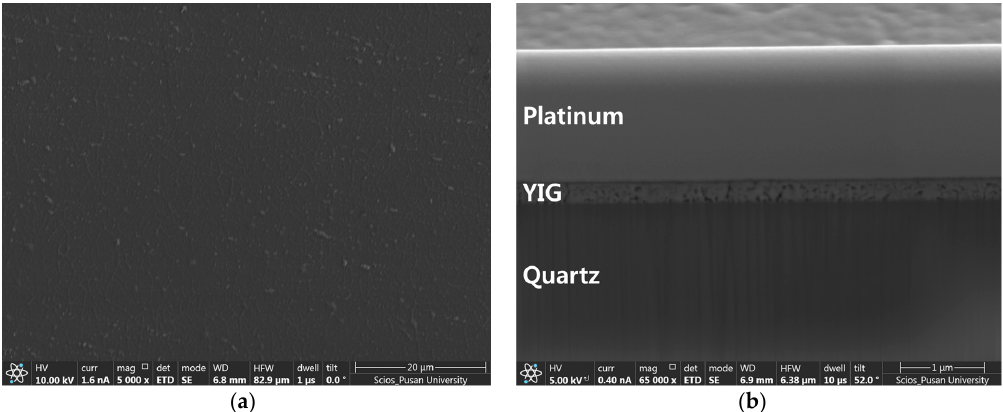
Figure 3. ( a ) A scanning electron microscopy image of the YIG sample (top-view); ( b ) A cross-section of the film. Note that the top platinum layer was deposited only for the ion milling by a focused ion beam, not for the thermoreflectance measurement.